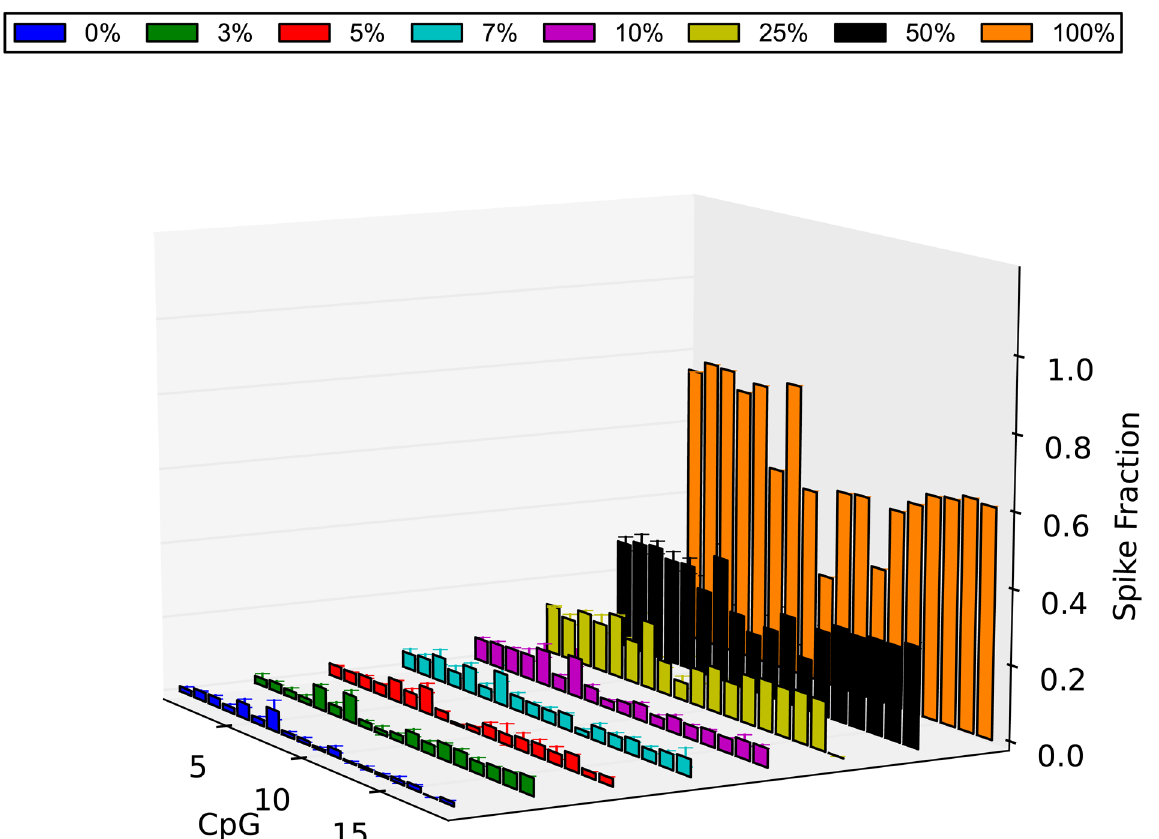
Fig 8. Methylation level of the EP6 DMR as determined by NGS. The methylation level of all the CpG sites of the amplified region of the EP6 DMR is plotted for all the spikes. Shown is the average value of each CpG in each spike as was calculated from 3 technical replicates (CVS 0% = blue, 3% = green, 5% = red, 7% = light blue, 10% = purple, 25% = yellow, 50% = black, 100% = orange). In order to calculate statistical significance of the methylation level of each spike, we created a dataset of average performance for each spike group and we compared these average performance datasets with the 0% CVS average performance set using a t-test. It was demonstrated that all the small spikes showed significantly higher methylation levels than the 0% CVS group [3% (P = 0.004), 5% (P = 0.004), 7% (P = 1.107e-05), 10% (P = 4.458e-06)]. Error bars = SD.